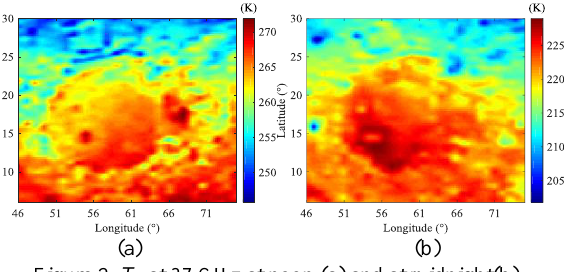
Figure 2. T B at 37 GHz at noon (a) and at midnight(b).